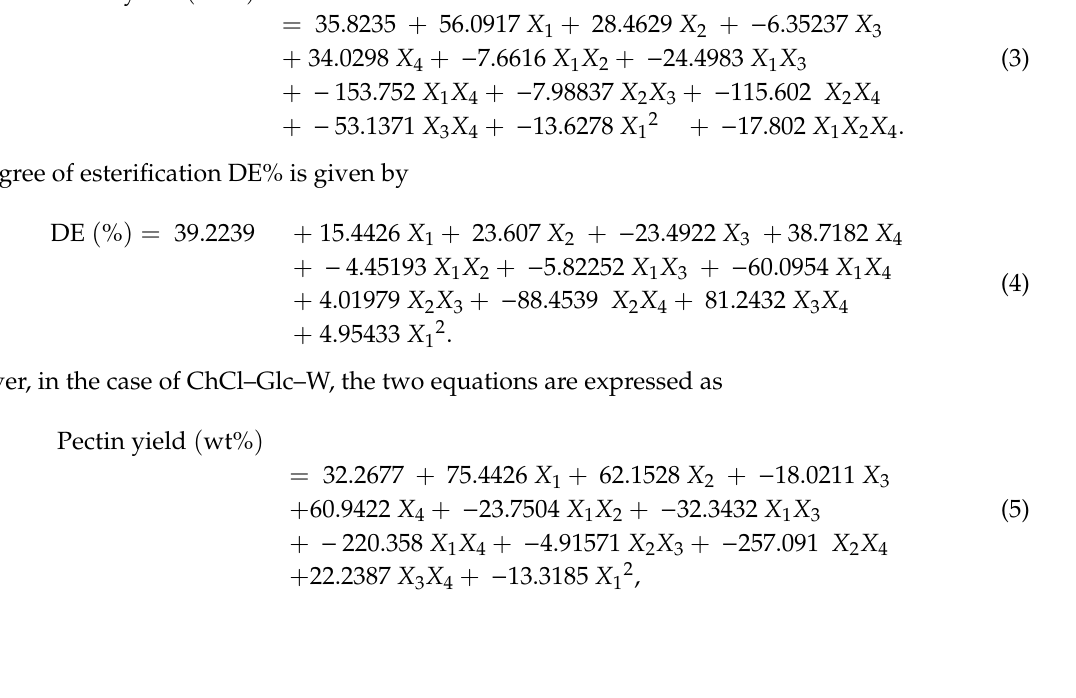
* T = temperature, t = time, L / S = liquid / solid